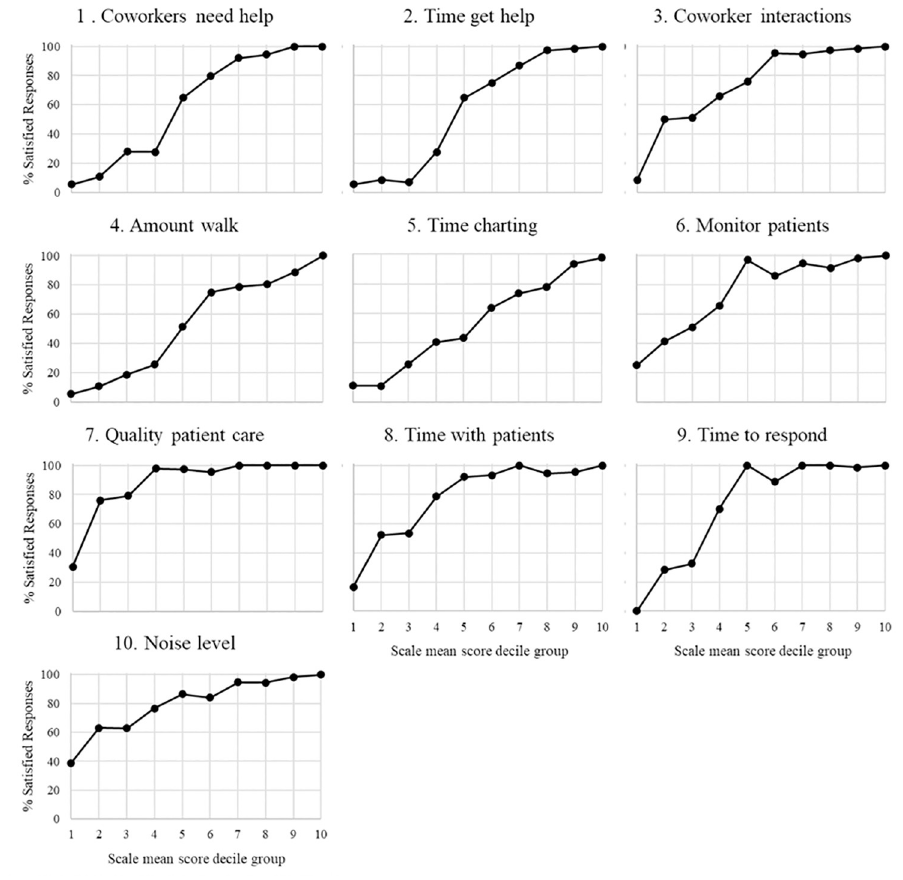
Fig 2. Phase 1 item response